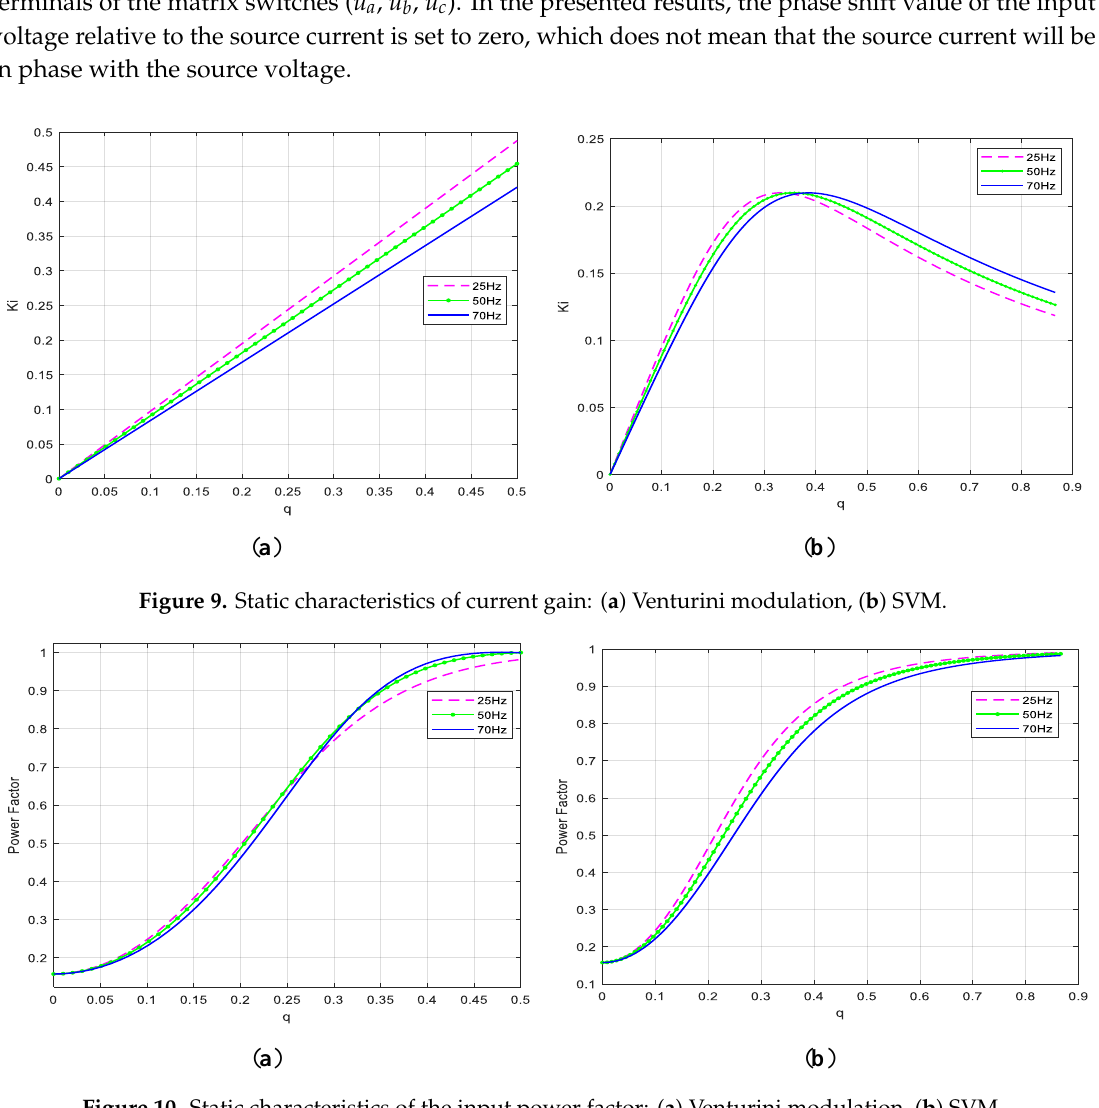
Figure 10. Static characteristics of the input power factor: ( a ) Venturini modulation, ( b ) SVM .